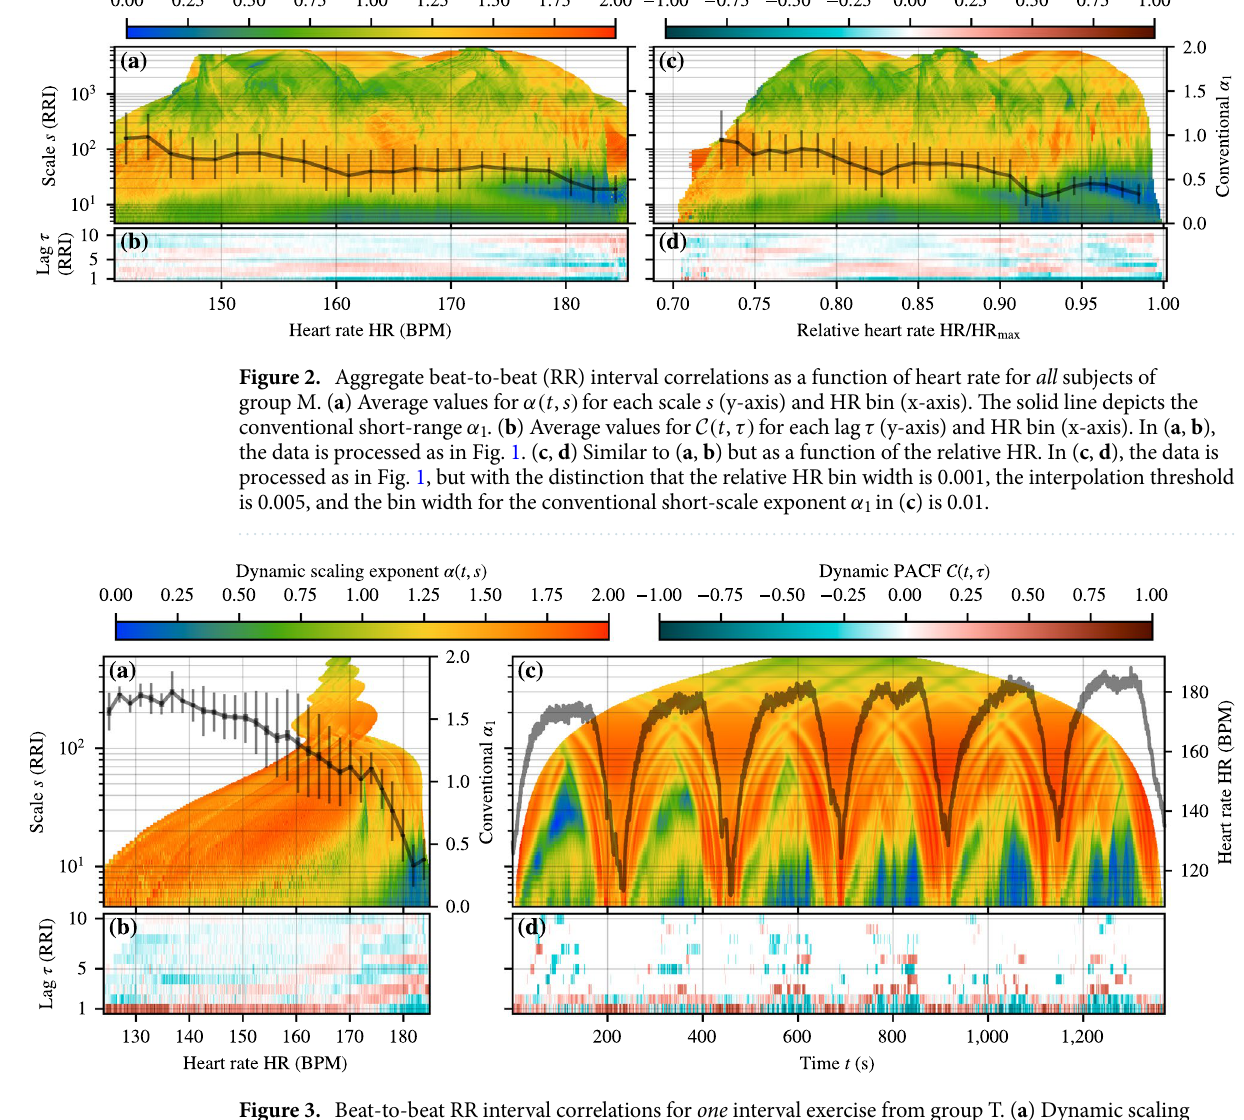
Figure 3. Beat-to-beat RR interval correlations for one interval exercise from group T. ( a ) Dynamic scaling exponents (DDFA-1) α( t , s ) (colors) and the conventional short-range α 1 (solid line) as a function of the binned HR. ( b ) DPACF-0 correlations C ( t , τ) as a function of the binned HR. ( c , d ) As in ( a , b ) but as a function of time, and in ( c ) the HR value is overlaid on the data. For details on the data processing, see the caption of Fig. pressed correlations at approximately 172 BPM with a weak tail towards short scales and lower intensities. This latter phenomenon is more visible in the DPACF data (Fig. 3b) as a weak band of anticorrelations surrounded by correlated bands at shorter and longer lags. Next, we study the typical behavior of RRI correlations when averaged over many running exercises of differ- ent intensity and duration, but for the same subject to avoid effects due to individual variability. The correspond- ing aggregated results from DDFA and DPACF analysis for the subject T07 are shown in Fig. 4, representing a total running distance of 1889 km. For this large data set, we obtain good statistics for the aggregated data and expect them to provide a reliable representation of the typical RRI correlations as function of the exercise intensity. Indeed, both DDFA exponent α( s ) and DPACF clearly show two distinct bands of anticorrelated RRIs (see Fig. 4a,b). The first band at moderate exercise intensity ( 125–170 BPM) displays a distinct, approximately ≈ exponential, trend in the DDFA anticorrelations shifting to longer scales as a function of the HR. It is plausible that the elevated scale anticorrelations appearing at lower intensities in Fig. 3 and for M4, M5, and M6 originate from this band of anticorrelations. The corresponding band in the DPACF results is split by a band of strong positive correlations. The latter band of anticorrelations at high exercise intensities ( (cid:31) 175 BPM) does not show a clear trend as a function of the HR, although there is tendency towards spanning to longer scales with increasing intensity. Notably, the anticorrelations remain present even at the shortest scales and lag. This is in contrast to some of the marathon data, where the highest-intensity anticorrelations appear at elevated scales. This could be